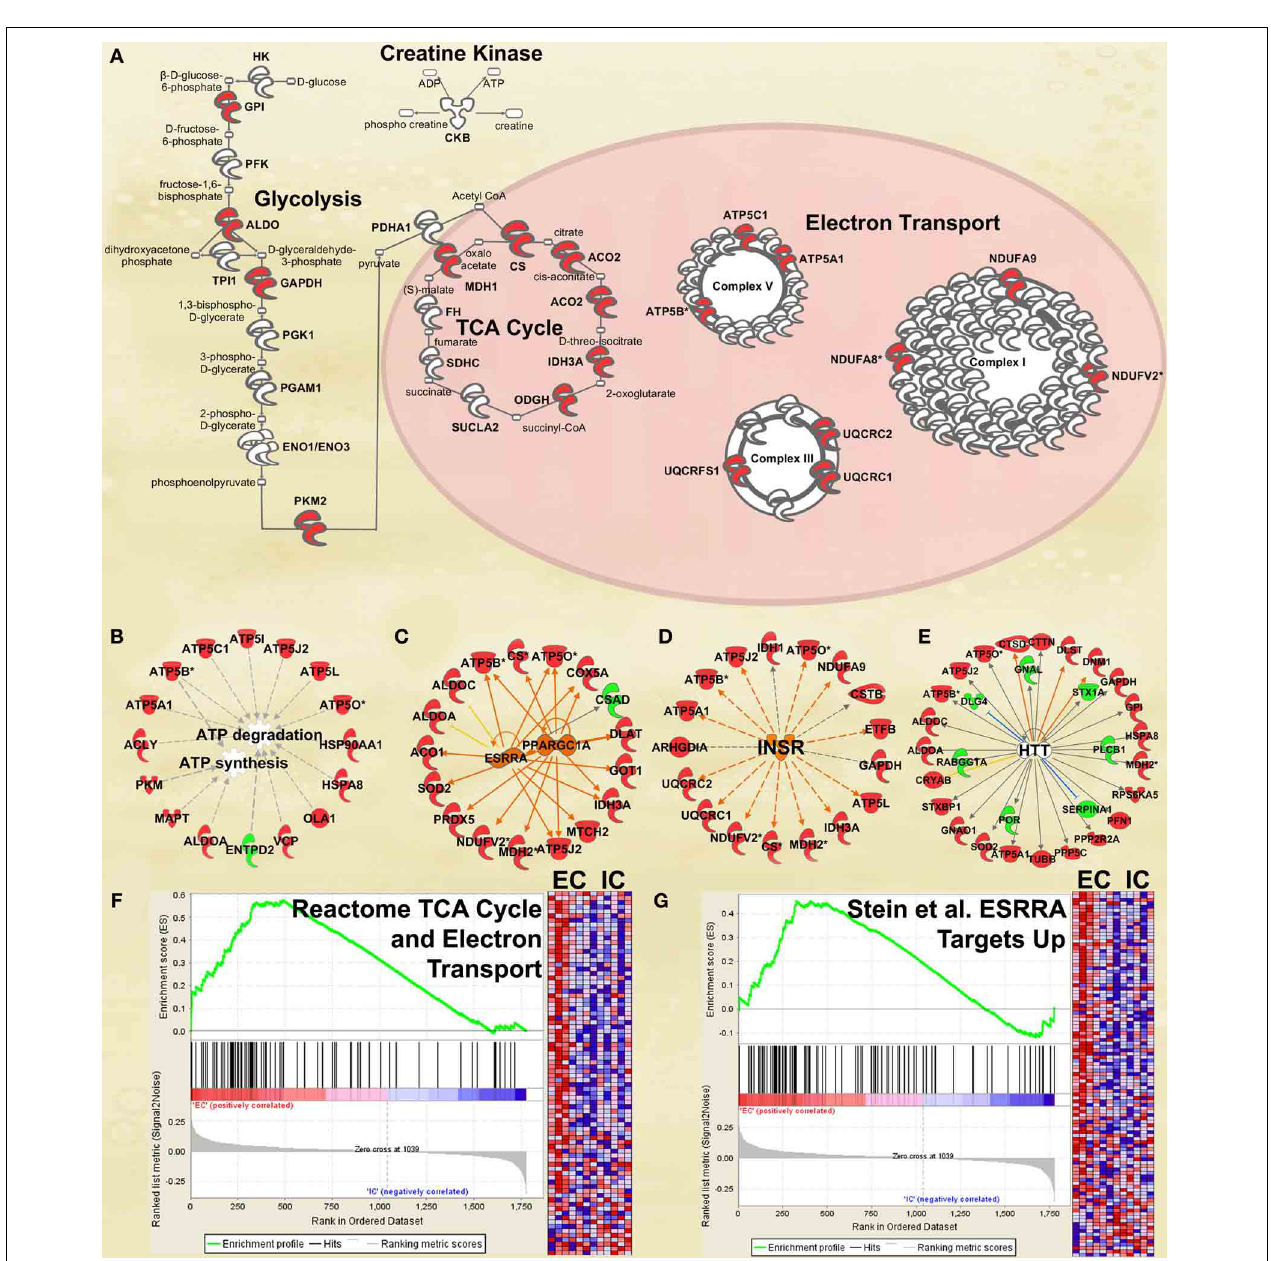
FIGURE 3 | IPA and GSEA findings illustrating the regulation of energy metabolism proteins by environmental enrichment. A complete list of results can be found in Supplementary Materials, as can a complete list of all proteins in each pathway. (A) Canonical pathways involved in energy metabolism from IPA. Proteins whose expression was significantly increased in EC rats are highlighted in red. TCA: tricarboxylic acid. Complexes I–V: mitochondrial respiratory chain complexes. (B) Proteins involved in ATP synthesis and degradation, a subset from the IPA biological functions analysis of Energy production ( Figure 2A ). Proteins whose